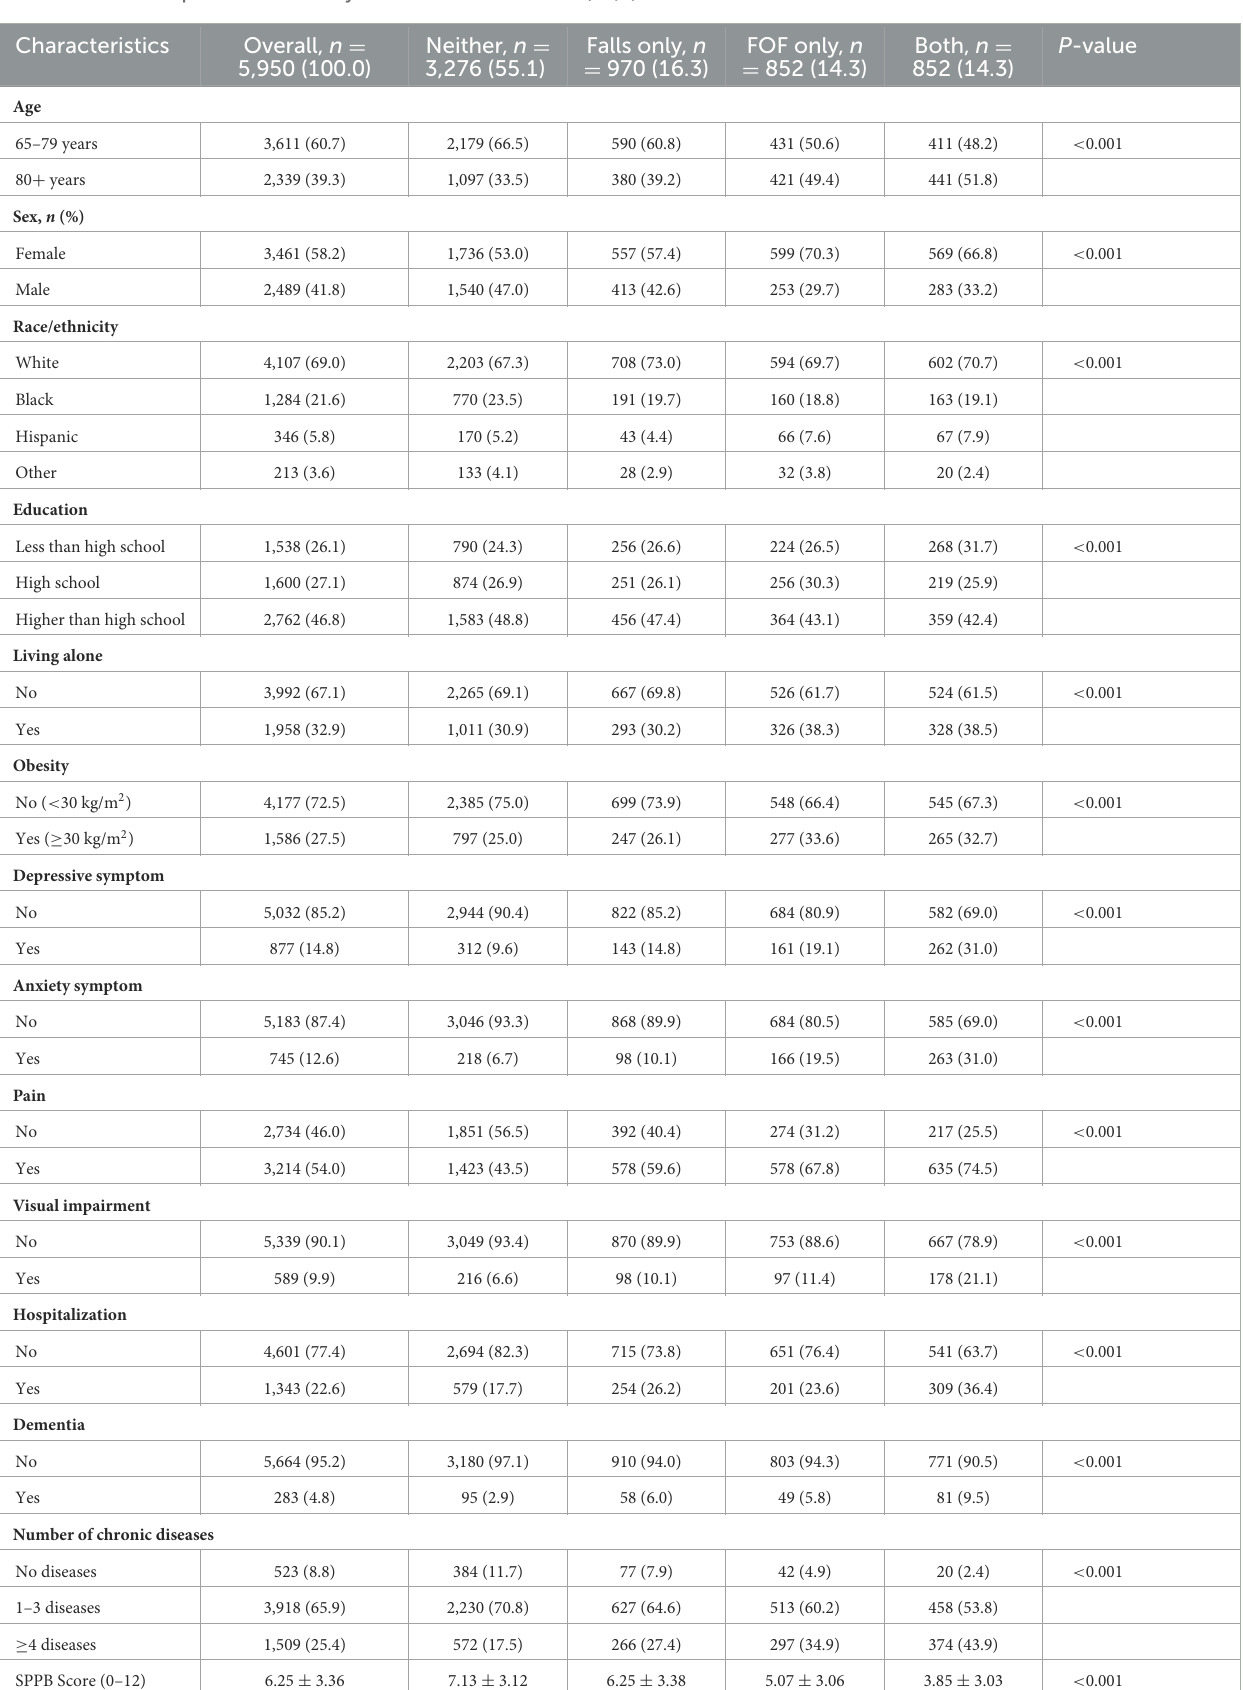
TABLE 1 Baseline sample characteristics by baseline falls and FOF status, n (%). Characteristics Overall, n = Neither, n = Falls only, n = 970 5,950 (100.0) 3,276 (55.1)